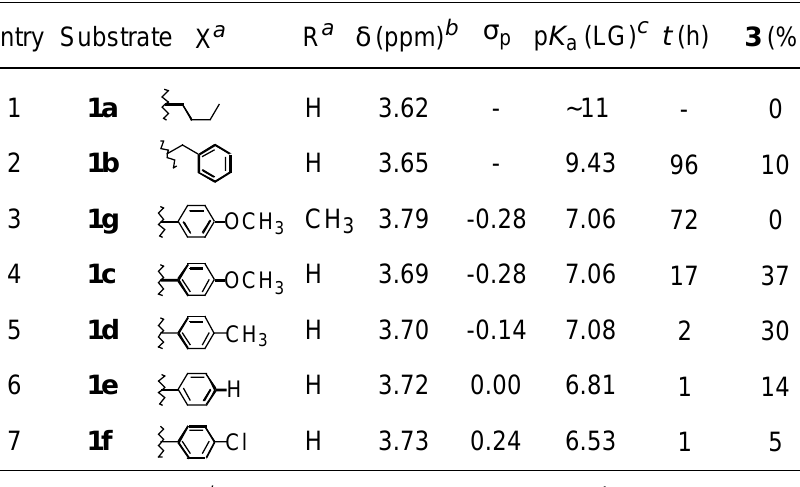
Table 1. Claisen self-condensation of thio(methyl)malonates 1a - g in THF at room temperature in presence of Mg(OAc) 2 and